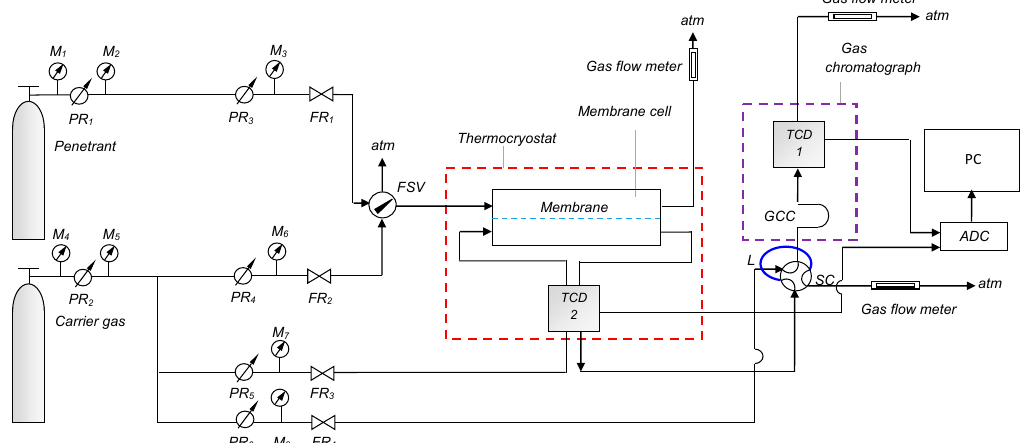
Figure 3. Experimental setup for permeability and diffusion coefficients measurements: TCD—Thermoconductivity Detector; GCC—Gas Chromatographic Column; L—Loop, SC—Sampling Cock; PC—Personal Computer; ADC—Analog-to-Digital Converter; M—Manometer; PR—Pressure Regulator; FR—Flow Regulator; FSV—Flow Switch Valve.